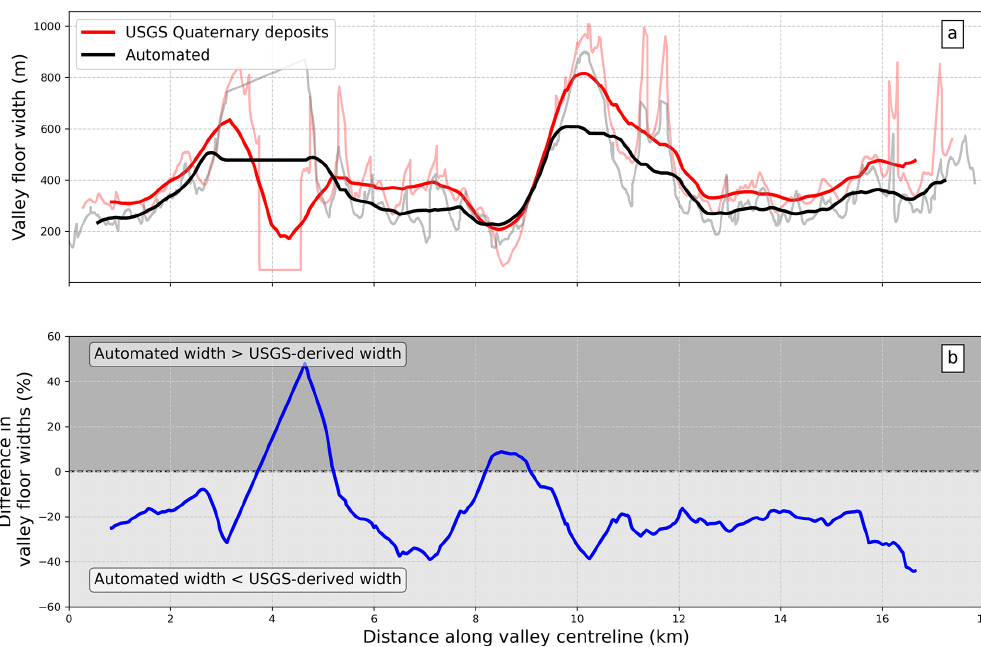
Figure 10. Results of valley floor width comparison for the Russian River. (a) Valley floor width from upstream to downstream along the centreline for the automated method (black) and derived from the USGS Quaternary maps (red). The light grey and red lines show the raw data, and the darker lines show a rolling average of width over a 500m window. (b) Percentage difference between the two datasets along the centreline, where positive values indicate a wider automated width than USGS-derived and negative values indicated a narrower automated width than USGS-derived.